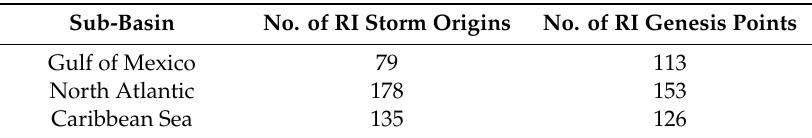
Table 1. Comparison of Gulf of Mexico, North Atlantic, and Caribbean rapid intensification (RI) storm origins and RI genesis sites.